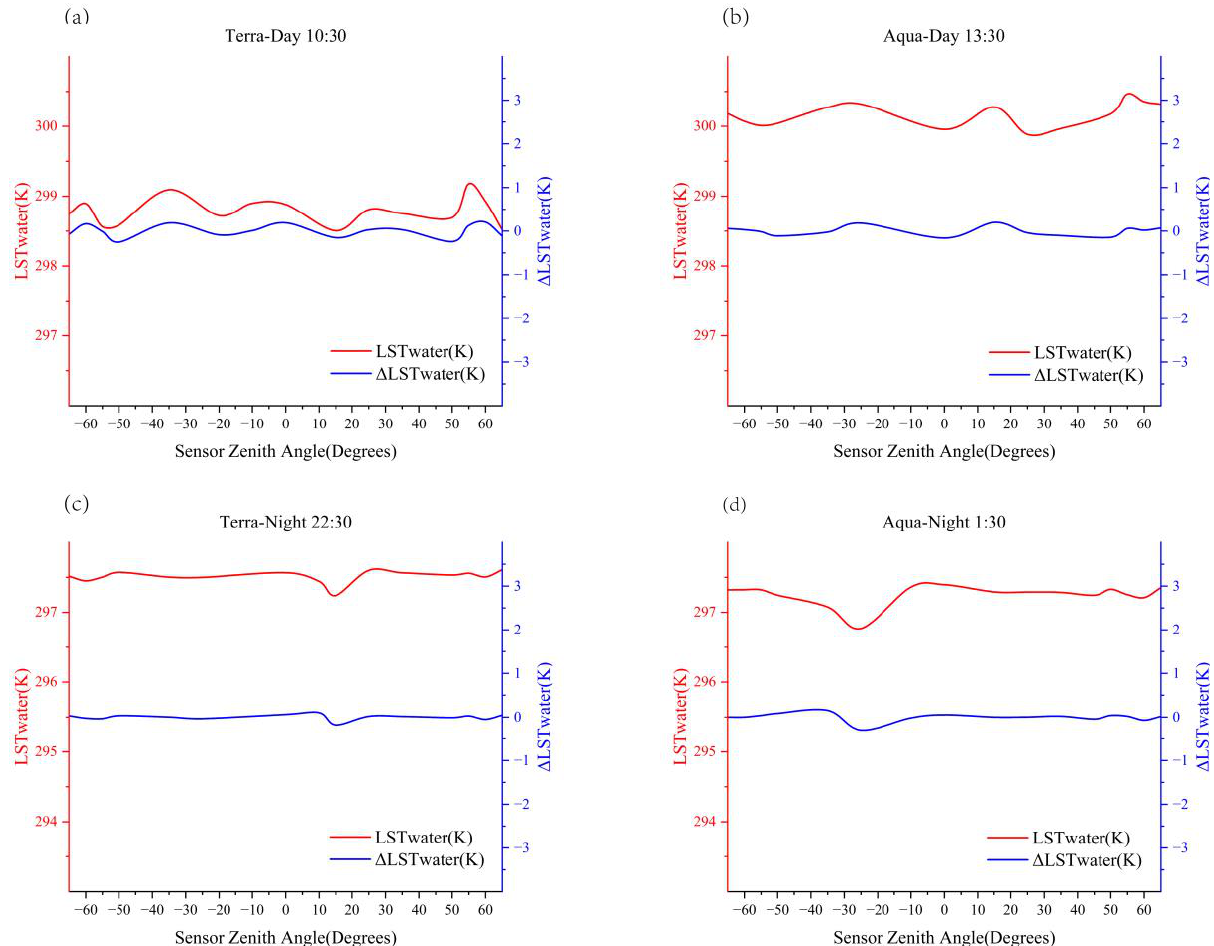
Figure 2. Distribution of LST water ( t ) (left y -axis, red) and ∆ LST water ( t ) (right y -axis, blue) at different sensor zenith angles (SZAs) ( x axis), during each satellite overpass. The subfigures ( a – d ) respectively display the distribution of LST water ( t ) and ∆ LST water ( t ) at different SZAs during satellite overpass at 10:30, 13:30, 22:30, and 01:30.